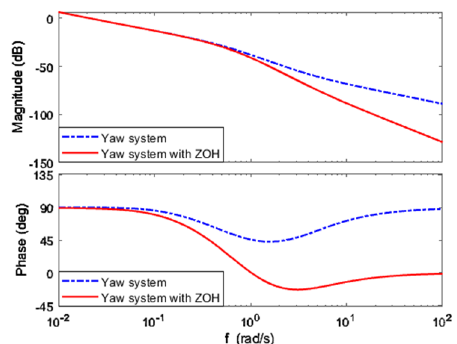
Figure 7. Bode plot of yaw system.